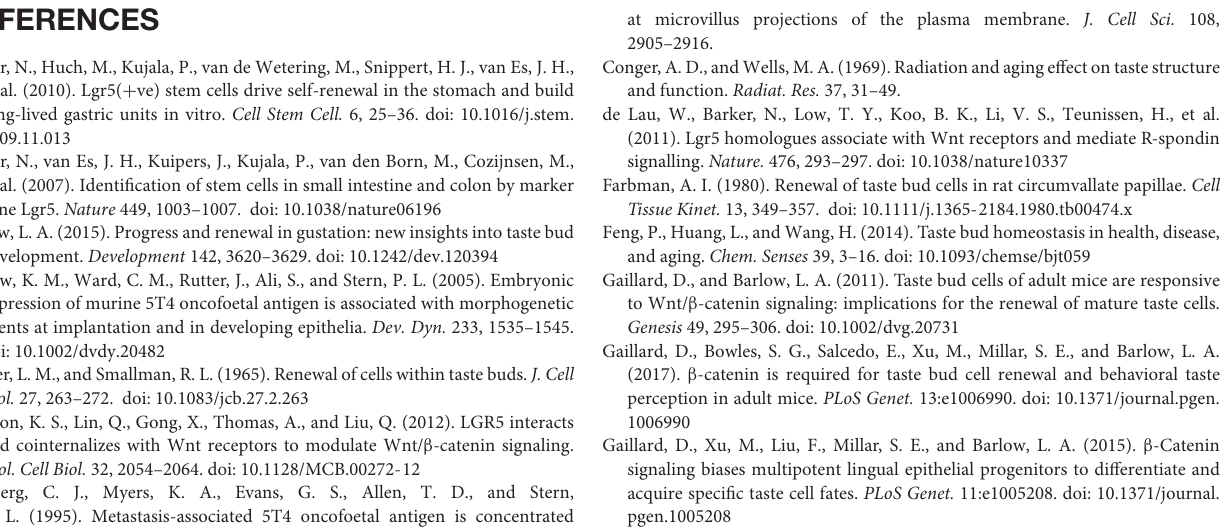
FIGURE S1 | 5T4 is expressed in the mouse tongue. (A,B) ISH of the CVP of 6-week-old WT mice using the 5T4 or Tas1r2 anti-sense RNA probe. Enlarged images of the regions enclosed by white squares in (A,B) are shown in (a and b). Scale bars, 100 µ m in (A) and 50 µ m in (a). (C) IHC of the CVPs of 6-week-old WT and 5T4 -KO mice using the antibody against 5T4 (green). Images are single confocal optical sections (2.02 µ m/slice). Scale bars, 100 µ m. FIGURE S2 | Levels of gene expression in CVPs from 5T4 -KO and WT mice, after normalization with 18S ribosomal RNA. RT-qPCR analysis of total RNA extracted from WT and 5T4 -KO CVPs. (A) Relative amounts of 18S ribosomal RNA were calculated using Actb mRNA as an internal control (NS not significant, Student’s t test with the Bonferroni correction; n = 4 per bar). (B) Relative amounts of several RNAs were calculated using 18S ribosomal RNA as an internal control ( ∗ p = 0.044 between WT and 5T4 -KO mice, Student’s t test with the Bonferroni correction; n = 4 per bar). Note that the level of Shh expression (a marker of taste precursor cells) calculated using 18S ribosomal RNA as an internal control was higher in 5T4 -KO mice than in WT mice. Similar results were obtained when Actb mRNA was used as the internal control ( Figure 4B